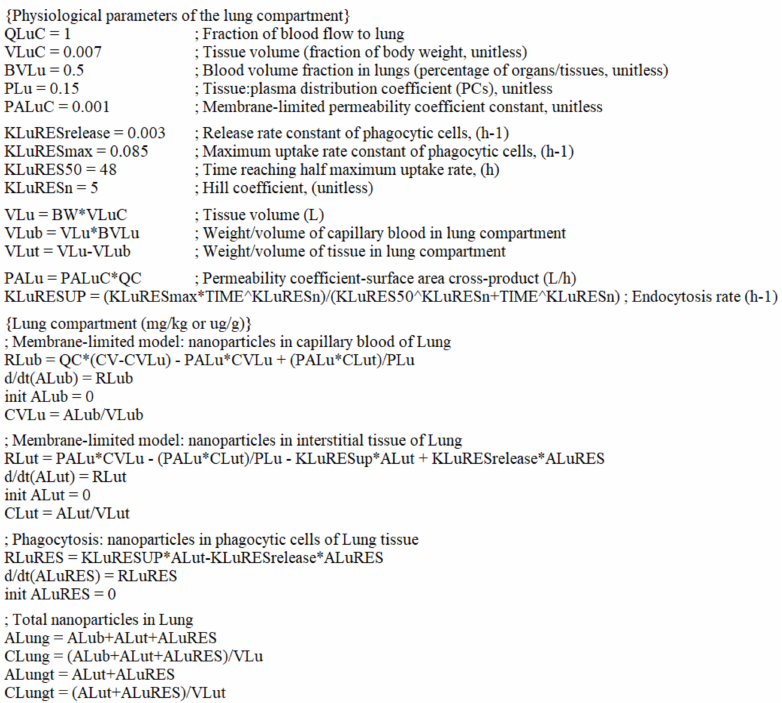
Figure 3. Original representation of the lung compartment equations using the syntax of the Berkeley Madonna platform. (Adapted with permission from https://pubs.acs.org/doi/10.1021/acsnano.9b0 8142 accessed on 1 April 2022. Copyright (2020) American Chemical Society. Further permissions related to the material excerpted should be directed to the American Chemical